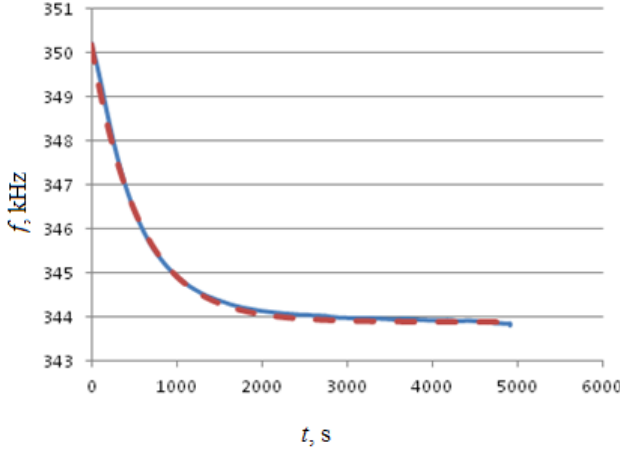
Figure 6. Initial transition process at startup of the experimental design. Full line shows experimental data, dashed line shows simulation data.